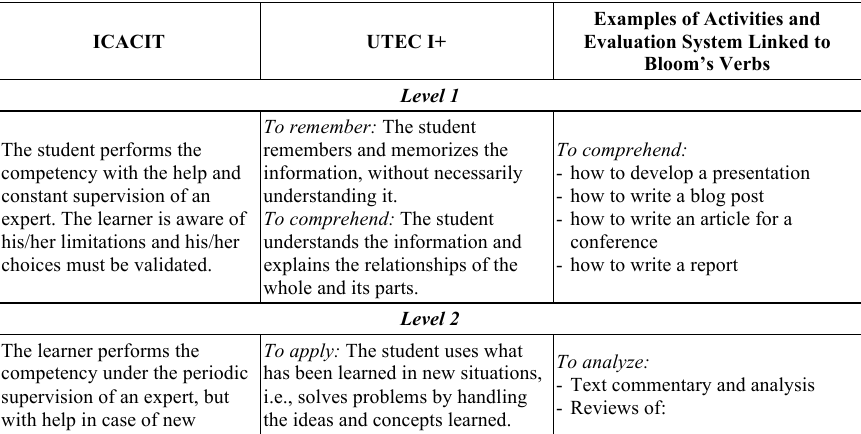
Table 2. The levels of competencies applied at UTEC drawn from the three competency levels described (based on Bloom’s taxonomy concept) Examples of Activities and ICACIT UTEC I+ Evaluation System Linked to Bloom’s Verbs Level